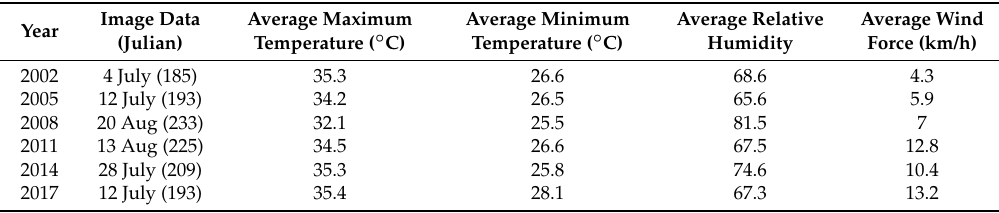
Table 1. The MODIS data and the weather conditions.